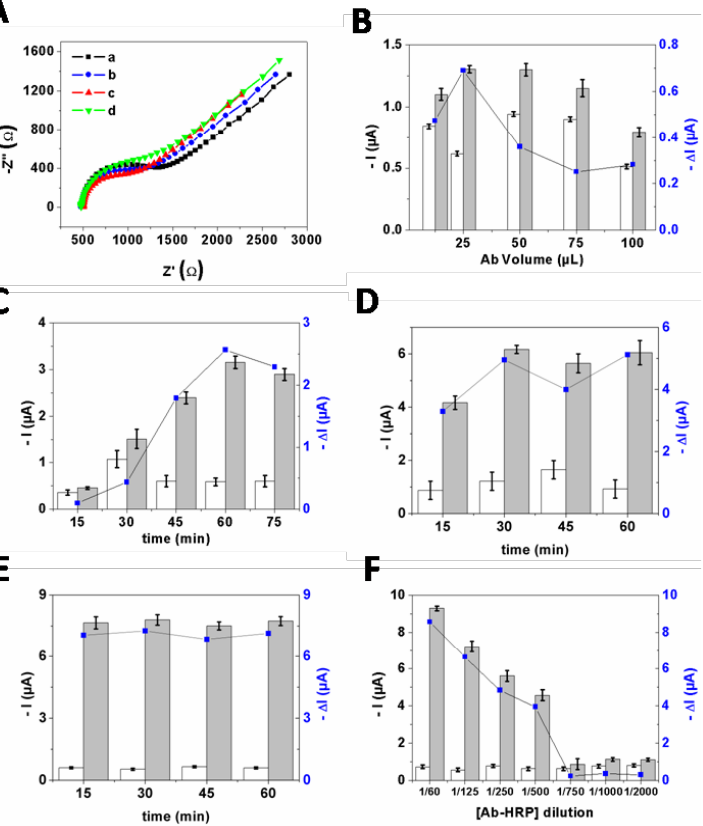
Figure 4. ( A ) Nyquist plots in 0.01 M PBS (pH 7.4) containing 5 mM K 3 Fe(CN) 6 /K 4 Fe(CN) 6 (1:1) of: (a) bare SPCE; (b ) Ab−AuNPs/SPCE; ( c ) F17A/Ab−AuNPs/SPCE; and (d) HRP−Ab/F17A/Ab−AuNPs/SPCE. Optimization of the experimental conditions: ( B ) the Ab (0.5mg·mL −1 ) volume used to react with AuNPs solution (500 µL, pH 9.5) for 30 min at RT; ( C ) the time of immobilization of Ab (0.5 mg·mL −1 ) onto AuNPs (500 µL, pH 9.5); ( D ) the time of immobilization of E. coli F17 – positive (10 6 CFU·mL −1 ) onto Ab−AuNPs/SPCE; ( E ) the time of immobilization of Ab−HRP (1/125) onto E. coli (F17 – positive)/ Ab−AuNPs/SPCE; and ( F ) the Ab−HRP concentration. Current measured before (white bars) and after (grey bars) immobilization of E. coli F17 – positive (10 6 CFU·mL −1 ). DI is the difference between the current measured before and after reaction with E. coli . The error bars stand for standard deviation recorded with three independent measurements ( n = 3).